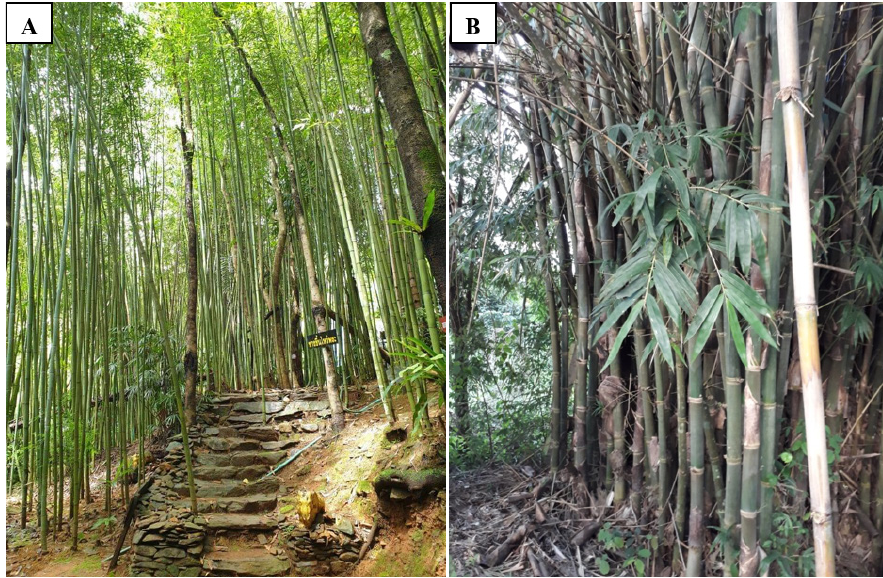
Figure 8: A: Phyllostachys sp. (a running bamboo) at Doi Chang Buddhist Park, Chiang Rai, Thailand; B: Dendrocalamus sp. (a clump forming) bamboo in Mae Fah Luang, Chiang Rai, Thailand. © Binu Samarakoon, Center of Excellence in Fungal Research, Mae Fah Luang University, Chiang Rai,